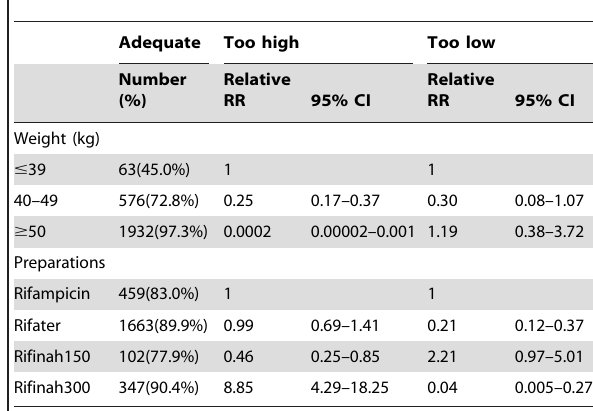
dosage of INH were body weight and preparations of INH. (Table 3) Patients treated with Rifater (rrr 12017.9, 95% CI 4215.9 – 34258.2) and Rifinah150 (rrr 16.9, 95% CI 7.6 – 37.6)